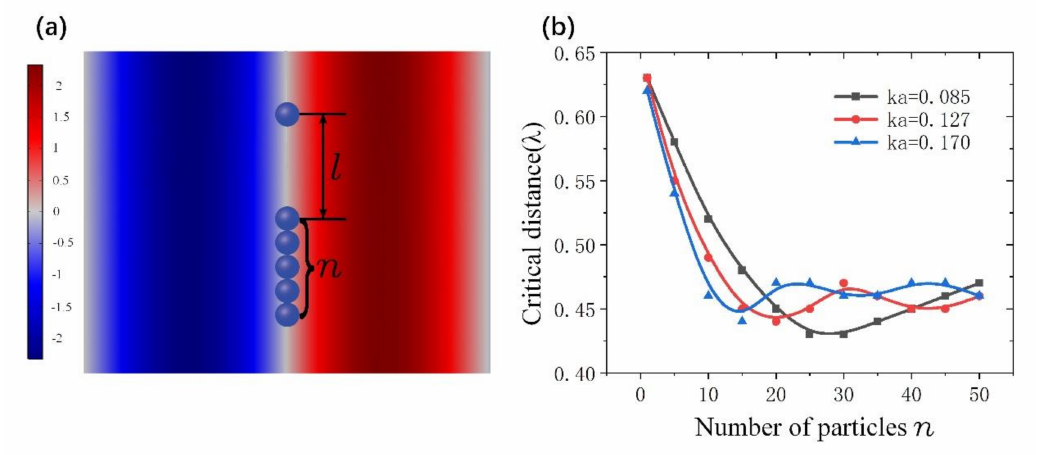
Figure 8. ( a ) The schematic for acoustic interaction between a cluster and a sphere. ( b ) The e ff ect of particle number and value of ka on critical